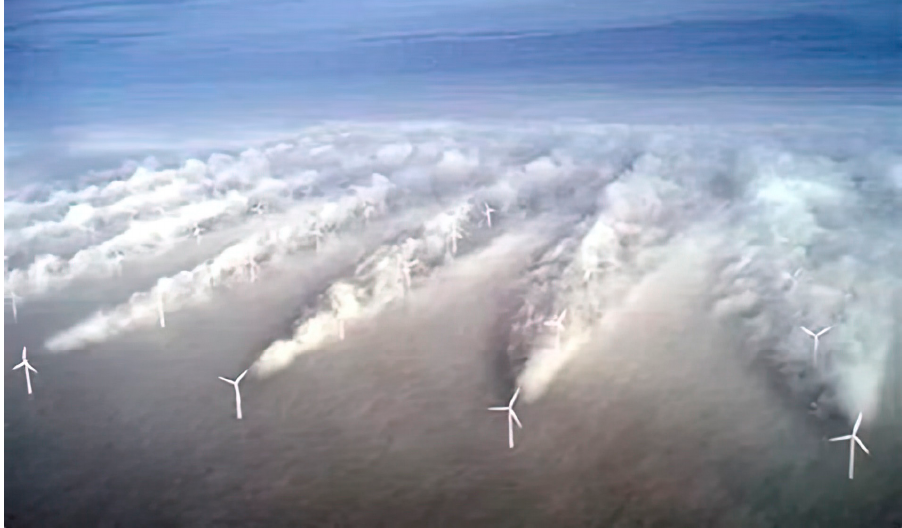
Figure 10. Picture of the wake effect at the Horns Rev offshore wind farm in Denmark [90].